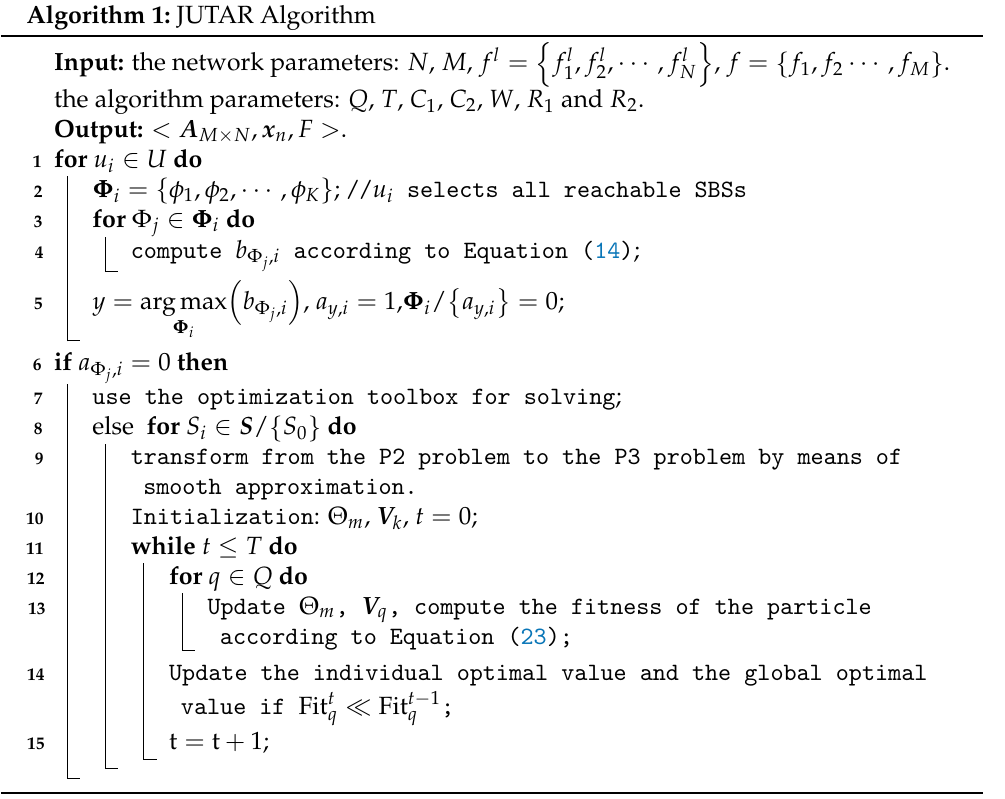
Algorithm 1: JUTAR